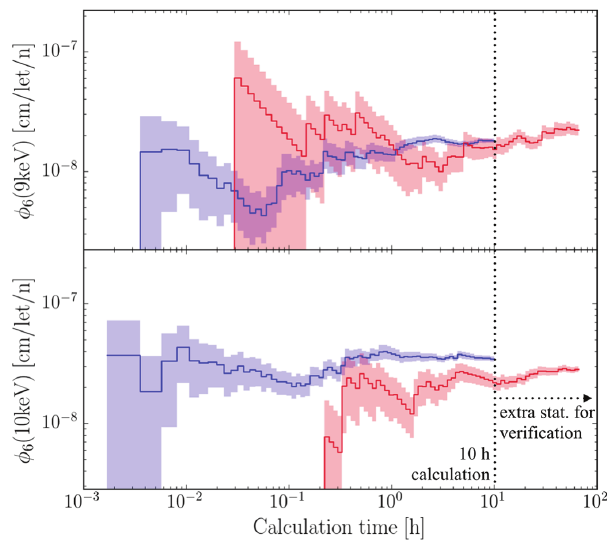
Fig. 7. Neutron flux estimation as a function of the calculation time, for the specific bin with a residual of 4.13 at 10h (bot- tom) and another bin for comparison (top). The red curve is the reference calculation without biasing, and the blue curve is the result with the